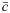
Scatter plots involving Fleiss’ kappa and three bar chart parameters.κCHS–Conger-Hubert-Schouten kappa, κF–Fleiss’ kappa, rv−coefficient of variation of the proportions of the rater bar chart, c¯–mean conformity number, Pm−proportion of trees marked in the 20% highest classes of the marking bar chart, see Section “Statistical measures of interrater agreement”.